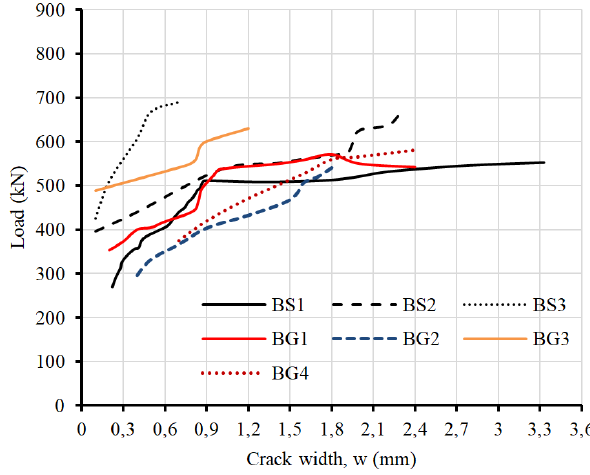
Figure 15: Crack width of tested